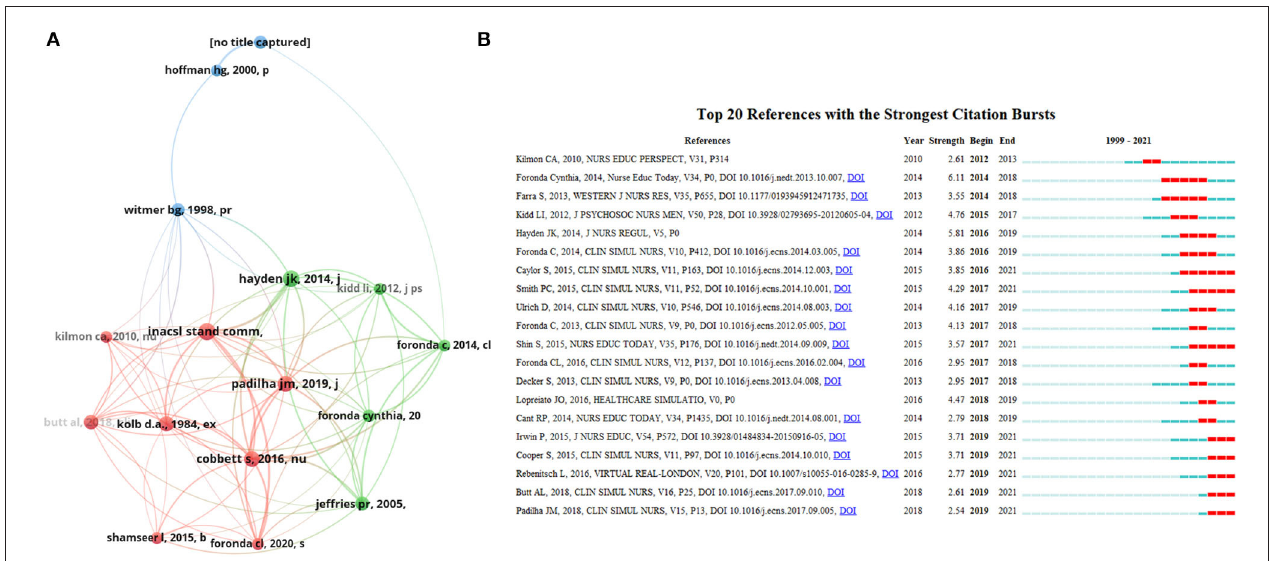
FIGURE 6 | (A) The co-citation network visualization map of references on virtual simulation in nursing field between 1999 and 2021. (B) The top 20 references with the strongest citation bursts on virtual simulation in nursing field between 1999 and 2021. The blue line represented the time from its first appearance to 2021, the red line represented the burst